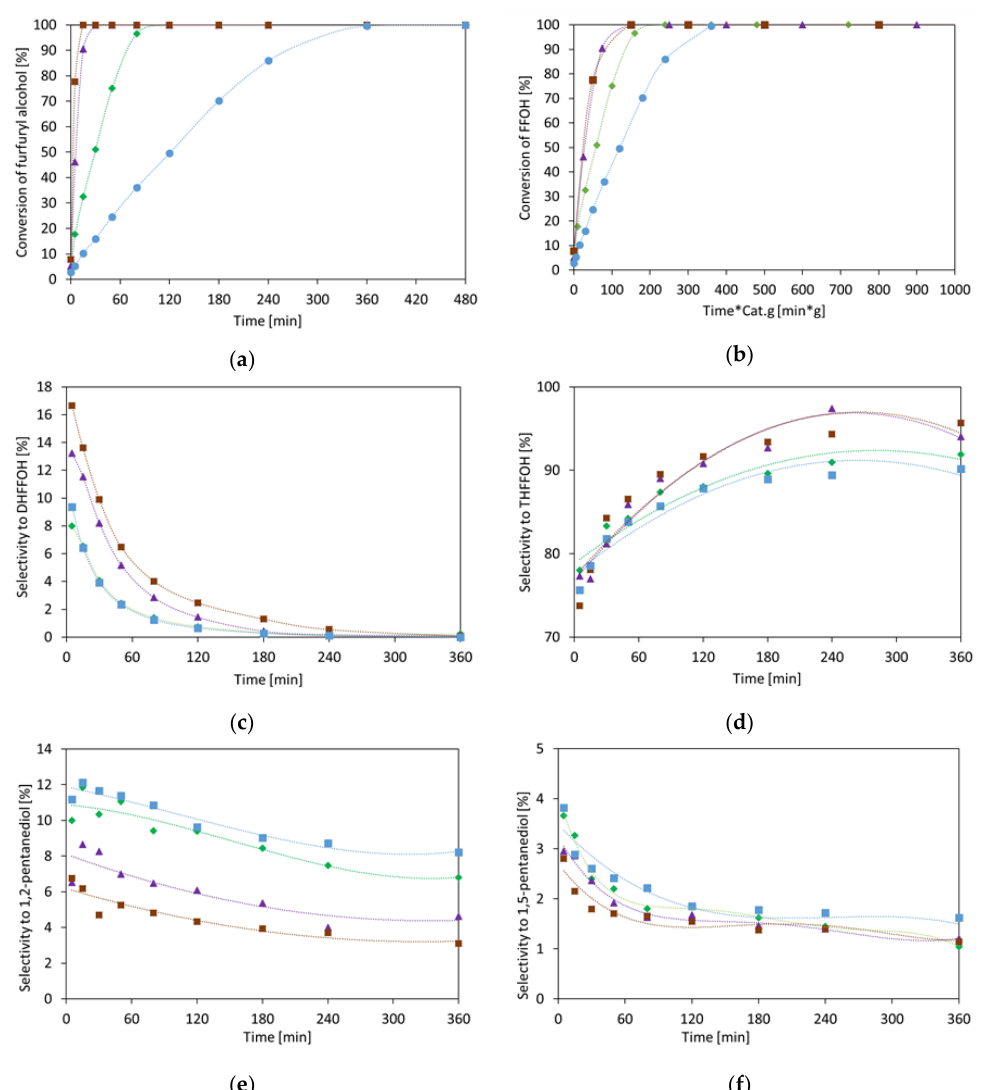
Figure 6 . ( a ) Conversion of FFOH, ( b ) hydrogen consumption. Selectivity to ( c ) DHFFOH, ( d ) THFFOH, ( e ) 1,2-pentanediol, and ( f ) 1,5-pentanediol at 70 °C in guaiacol:furfuryl alcohol ( e ) 1,2-pentanediol, and ( f ) 1,5-pentanediol at 70 ◦ C in guaiacol:furfuryl alcohol mixtures of 90:10, 80:20, mixtures of 90:10, 80:20, 50:50, 0:100 mol:mol. 50:50, 0:100